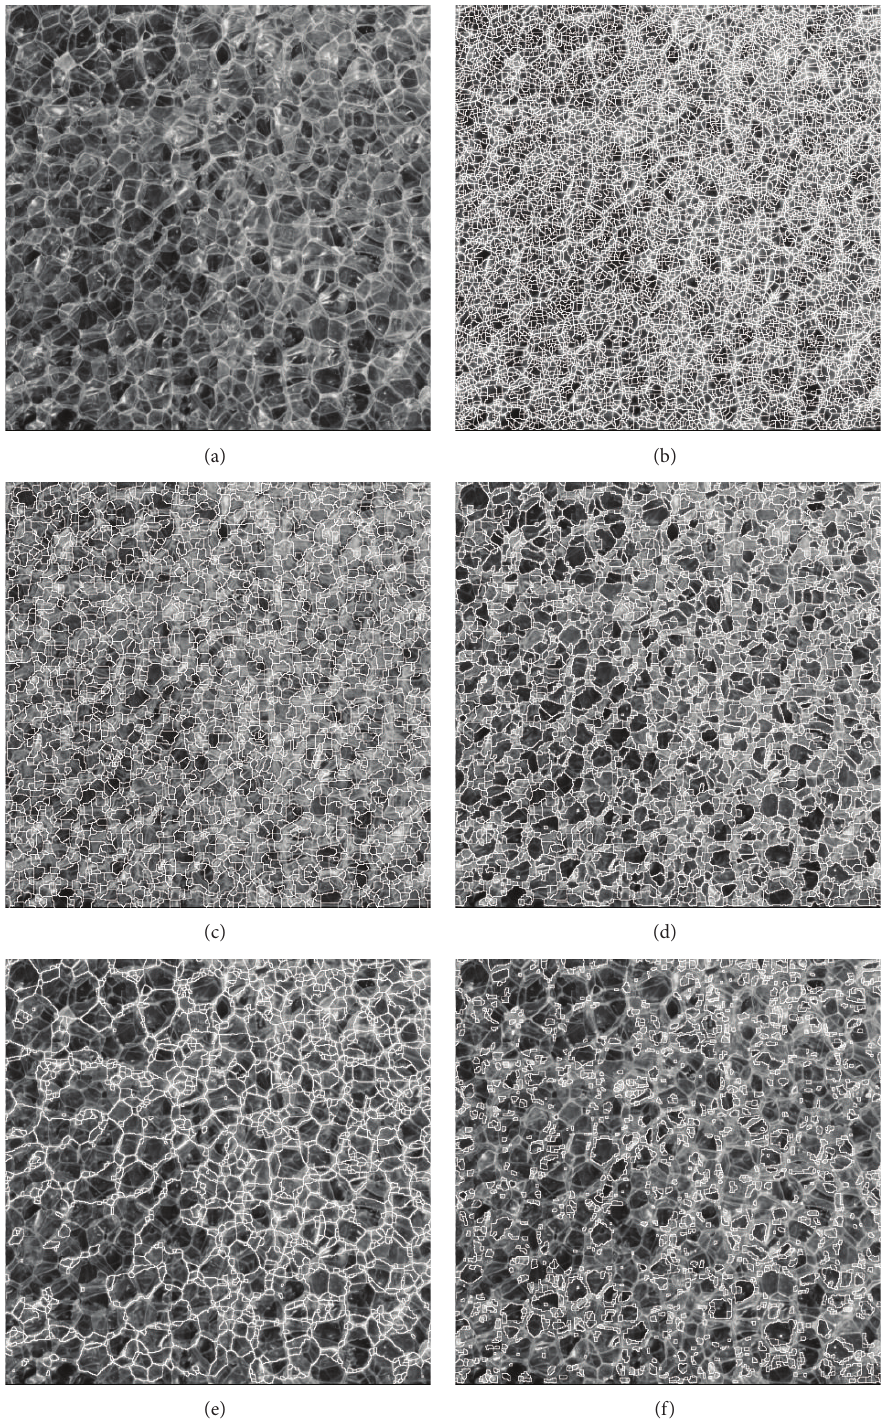
Figure 2: From left to right and from top to bottom: original image, result of traditional watershed algorithm, result of final multi-scale gradient algorithm, result of [4] algorithm, result of [15] algorithm, and result of the new